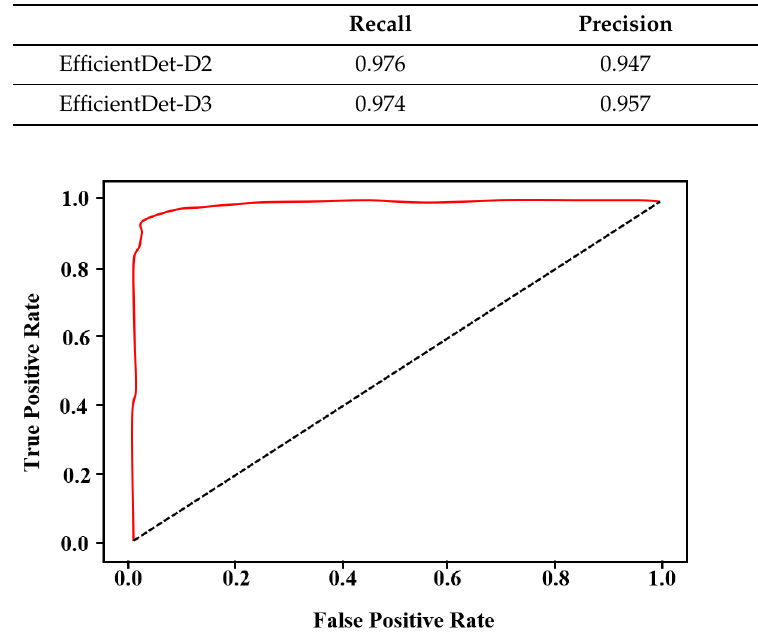
Table 2. Performance comparison of EfficientDet-D2 and EfficientDet-D3.